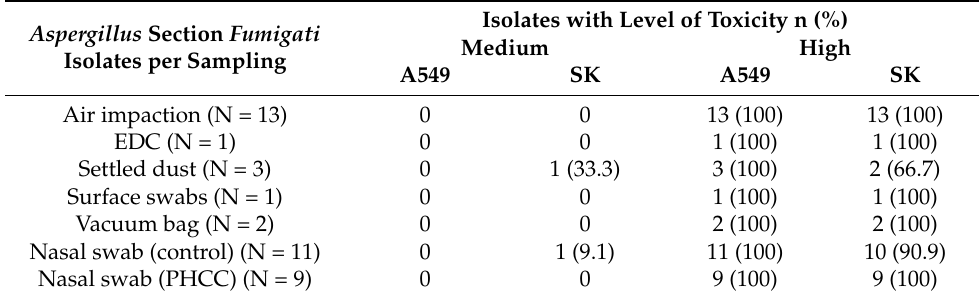
Table 4. Level of cytotoxicity of the Aspergillus section Fumigati isolates.